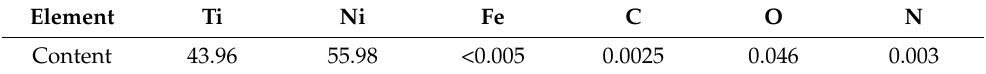
Table 1. Chemical composition of TiNi pre-alloyed powder (wt.%).